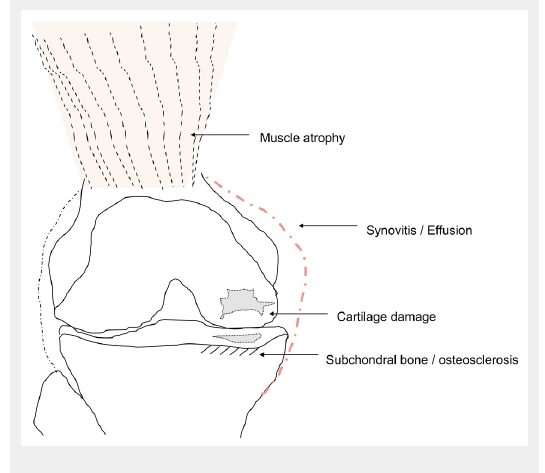
Schematic illustration of OA as a “whole joint disease” with structures involved in OA pathology. Muscle atrophy can cause OA, but is also seen as a consequence of OA, e.g., pain-induced. Synovitis with secretion of proinflammatory cytokines into the joint space correlates with pain and radiological progression. Cartilage degradation is the hallmark of OA. Subchondral bone pathology is also observed in OA, ultimately leading to osteosclerosis.